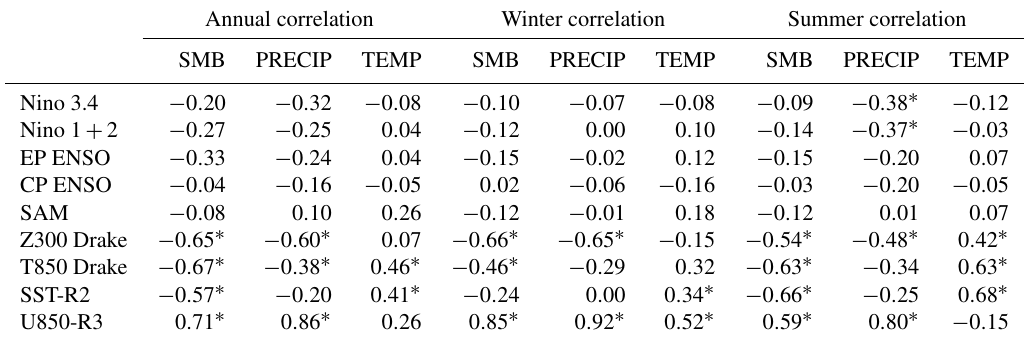
Table 2. Correlation between indices of the main modes of interannual variability influencing Patagonia (and other custom indices) and the time series of spatially averaged fields of SMB, accumulated precipitation, and mean temperature.